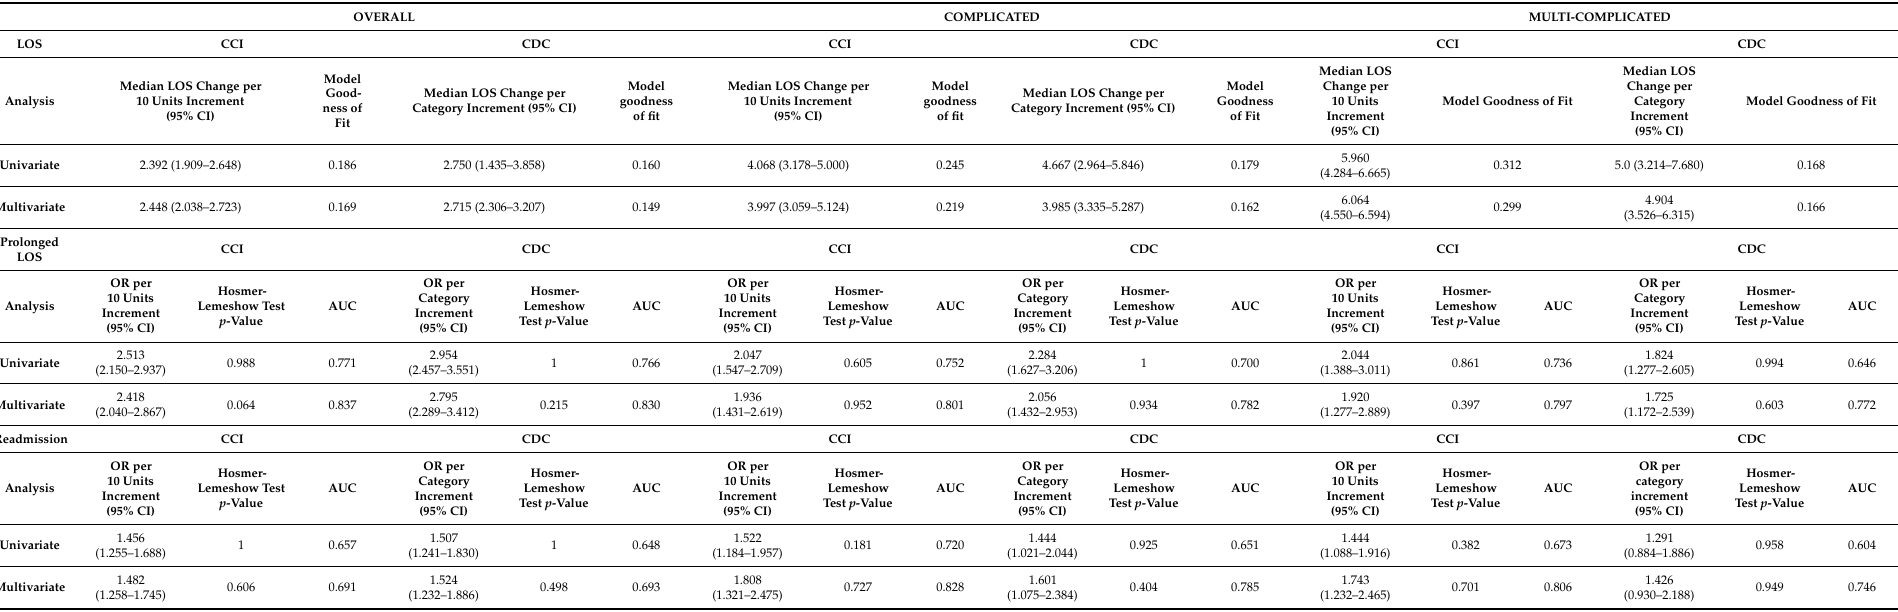
Table 3. Univariate and multivariate analysis for LOS, prolonged LOS and